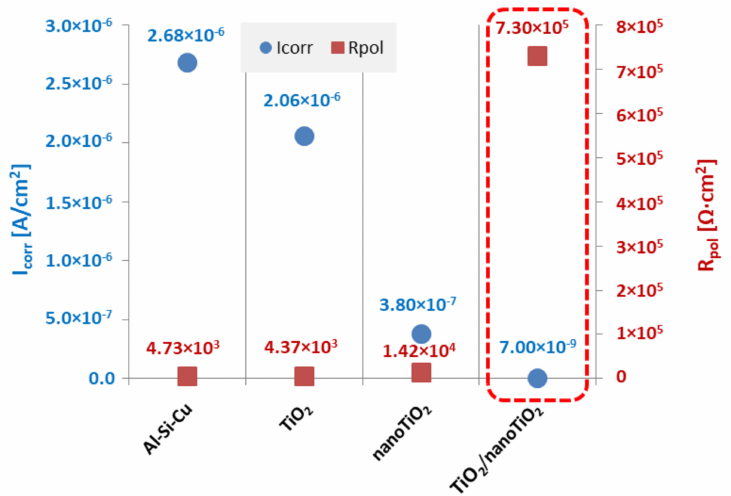
Figure 13. Summary of corrosion parameters’ values from Tafel analysis of investigated samples in 3.5% NaCl